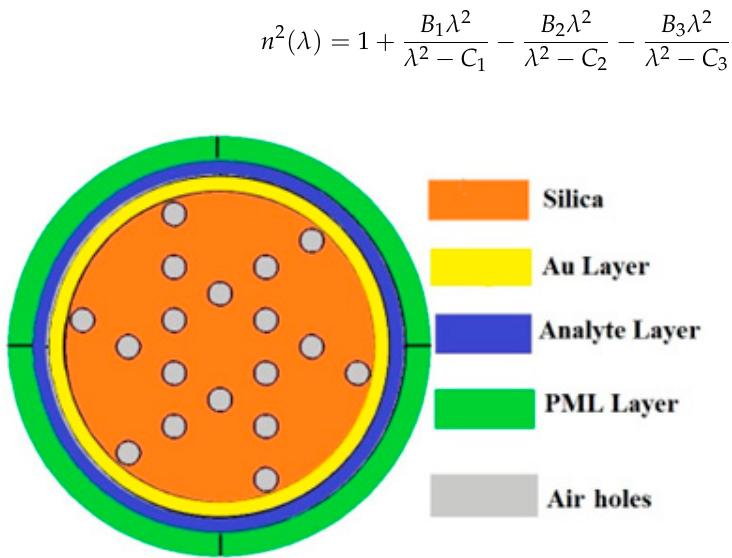
Figure 1. Cross-section schematic of proposed PCF-SPR biosensor.